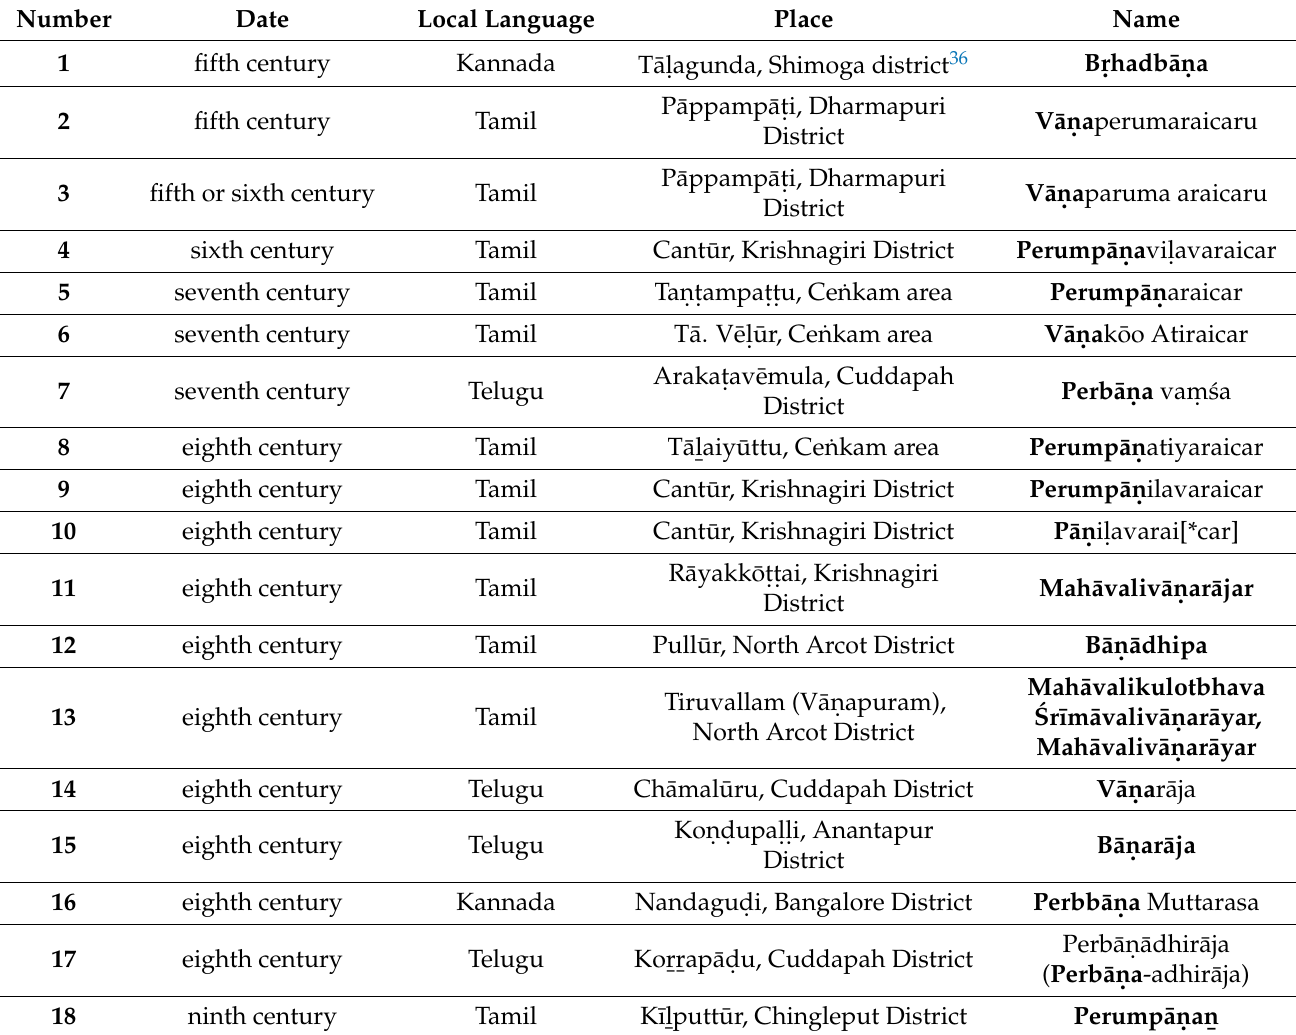
Table 1. References to the B¯an.as in Various